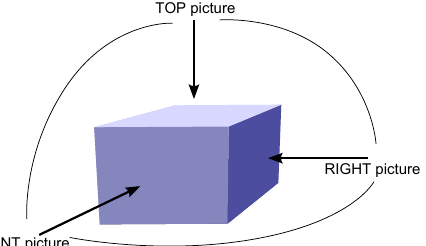
Figure 2. Directions from which robot takes three main images of